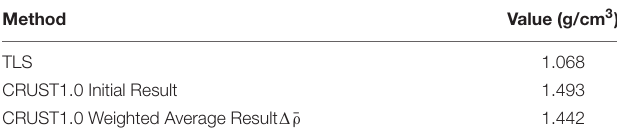
TABLE 3 | Density contrast for the whole study area.